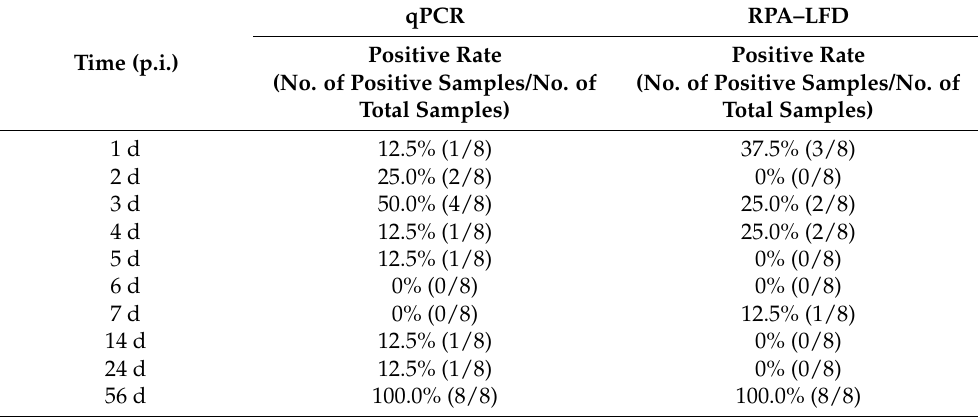
Table 3. Detection efficacy of the qPCR and RPA–LFD assay for goat schistosomiasis japonica at different stages.